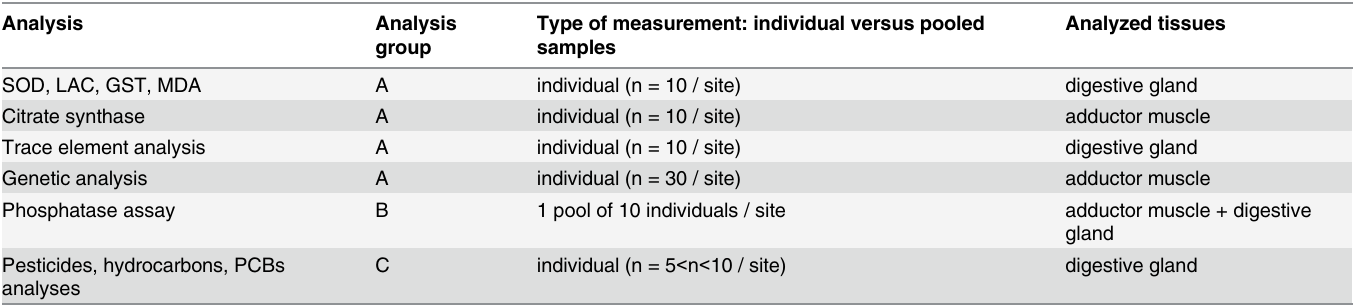
Table 1. Summary of our sampling design. Analyses of two types of chemical contaminants (trace metals and organic pollutants), biomarkers, phospha- tases and genetic data were conducted on natural populations of variegated scallops ( Mimachlamys varia ) sampled at four sites. Analyses listed under the same “ Analysis group ” were conducted on the same variegated scallop individuals. All analyses but one were performed for each individual (sample size per site is shown in parentheses). The remaining analysis was conducted on a pool of 10 individuals per site. The type of tissue that was analyzed is indicated in the last